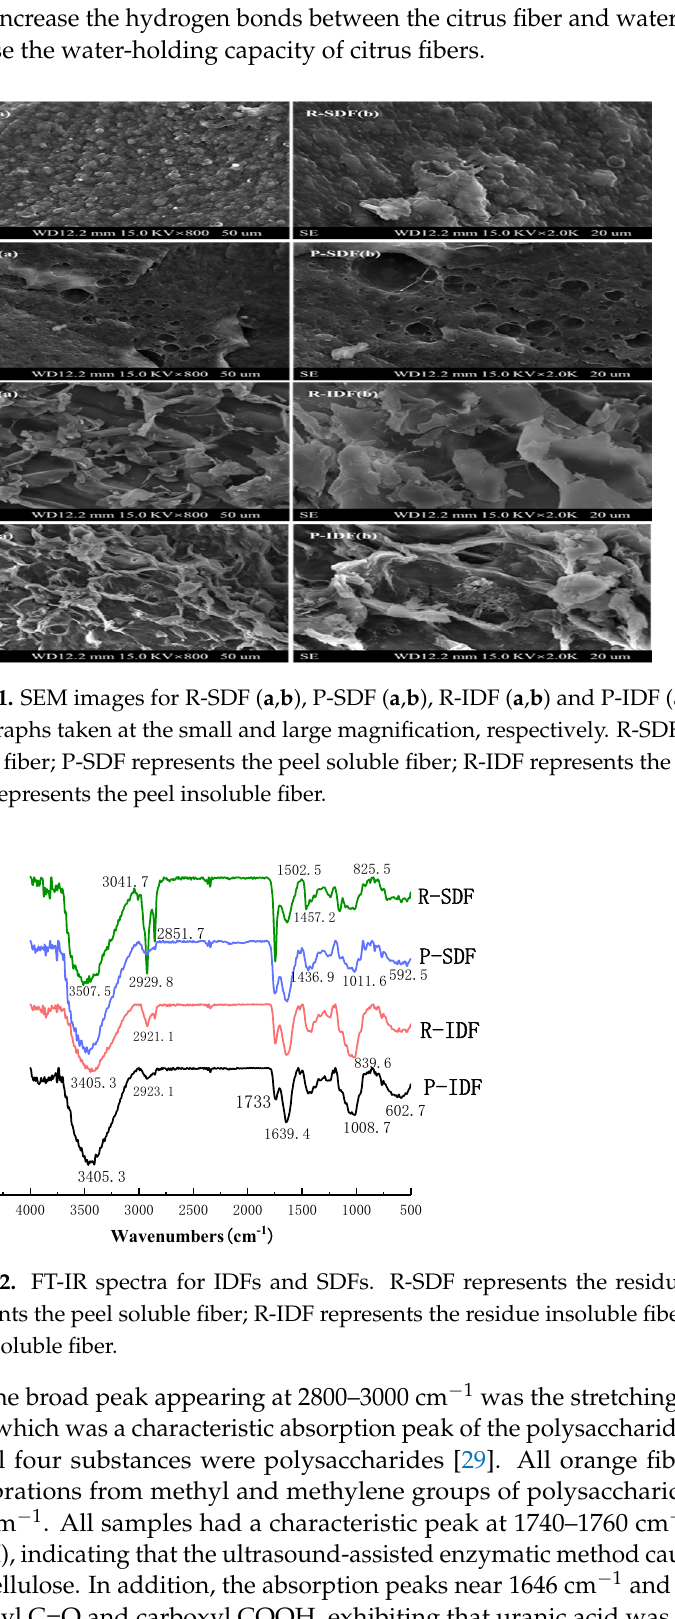
Figure 2. FT-IR spectra for IDFs and SDFs. R-SDF represents the residue soluble fiber; P-SDF represents the peel soluble fiber; R-IDF represents the residue insoluble fiber; P-IDF represents the peel insoluble fiber.